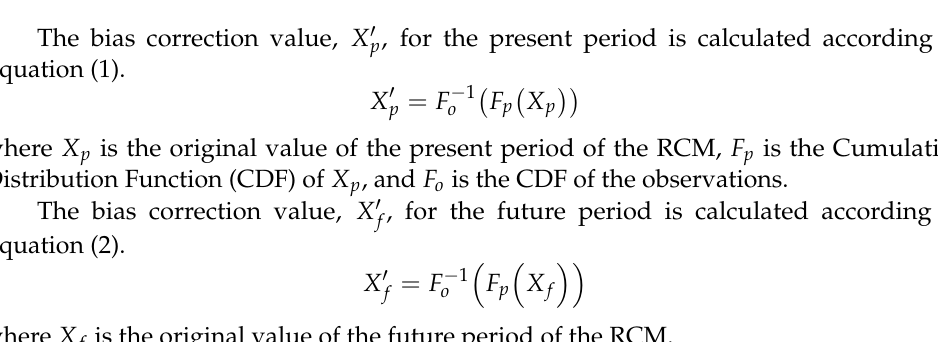
Figure 3. Simple principle scheme of the bias correction